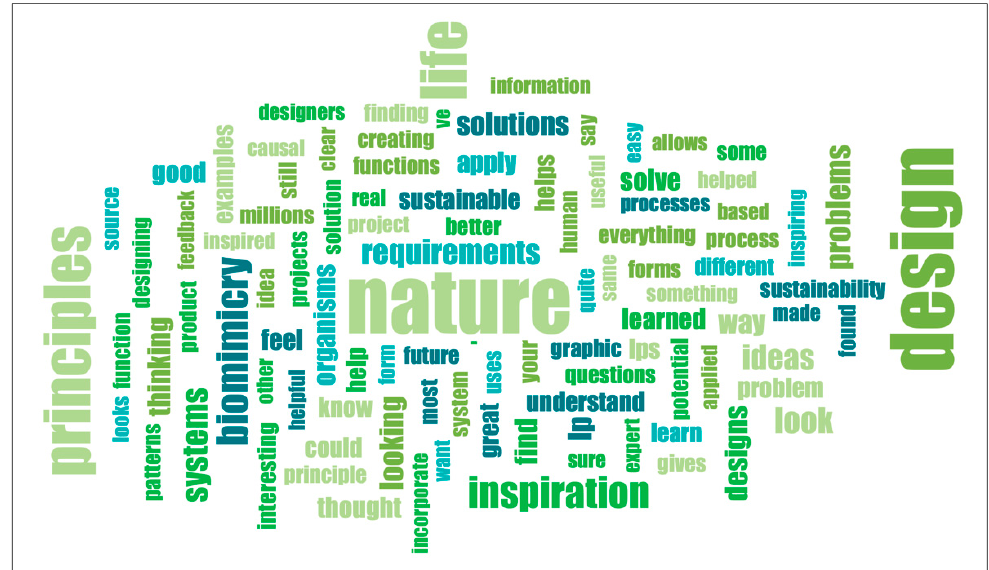
Figure 15. Word cloud of combined free response answers in survey (Q3, 5, 7). Generated in MAXQDA2020.